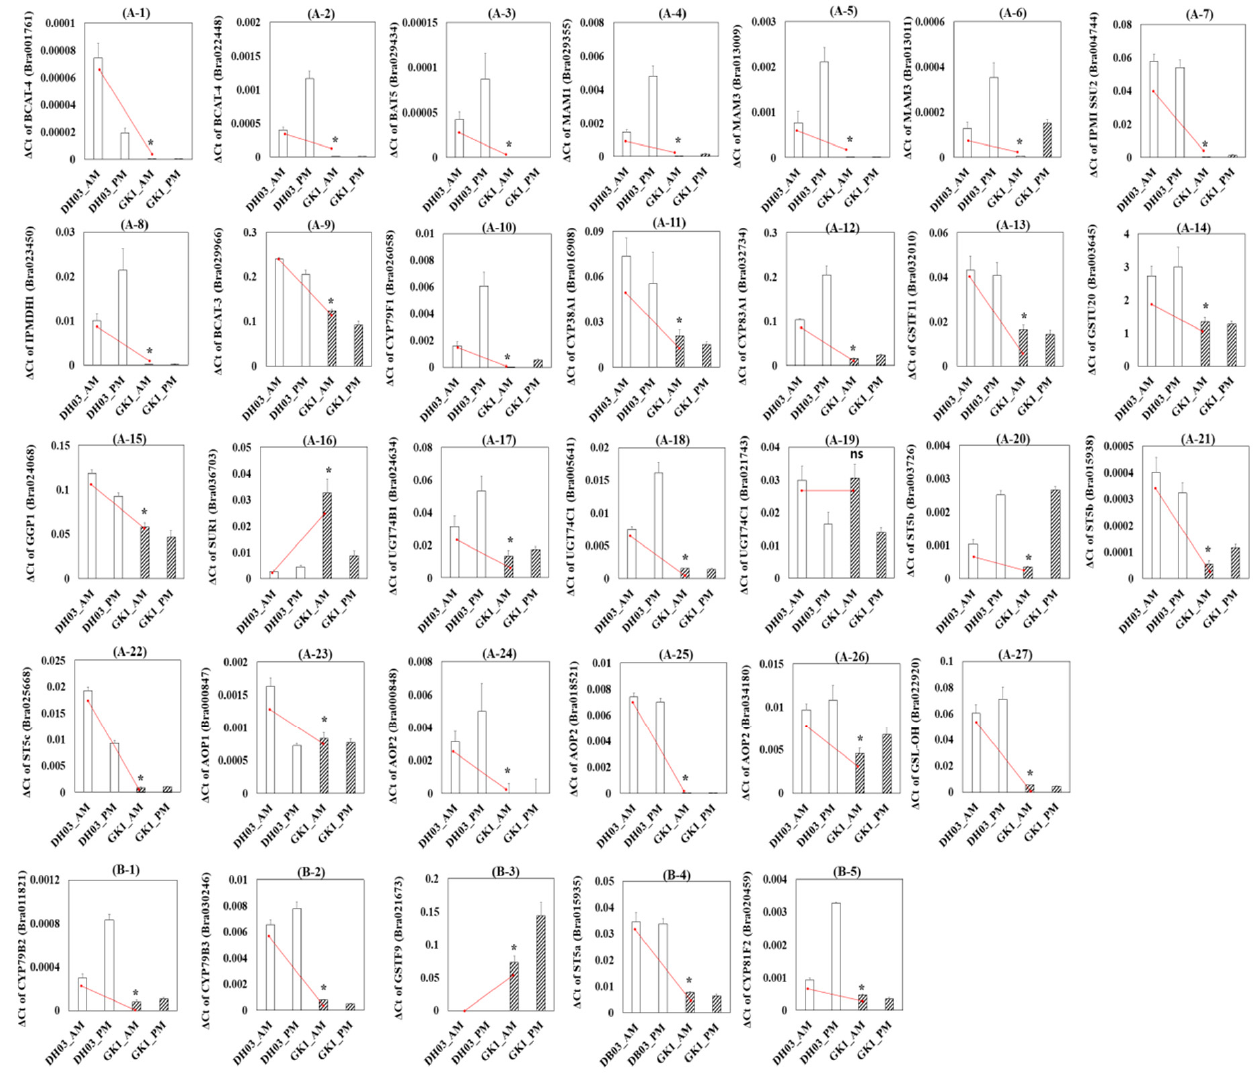
Figure 6. RT-qPCR validation of RNA-seq data. For RT-qPCR of the diurnal expression of GSL synthesis-related genes in DH03 and GK1 Chinese cabbage sprouts, samples were collected at 10 a.m. and 5 p.m. in liquid nitrogen and stored at − 80 ◦ C prior to lyophilization. The DEGs detected by RT-qPCR showed the same trend as those identified by RNA-seq (Figure 5). Genes in the aliphatic GSL pathway ( A-1 – A-27 ) and indolic GSL pathway ( B-1 – B-5 ). Each value is the mean of three biological replicates, and error bars indicate the standard deviations (SDs). * p < 0.05 compared to the negative control (DH03). CYP79B2c (Bra017871), GSTF9 (Bra022815), and BAT5 (Bra000760) were not detected.